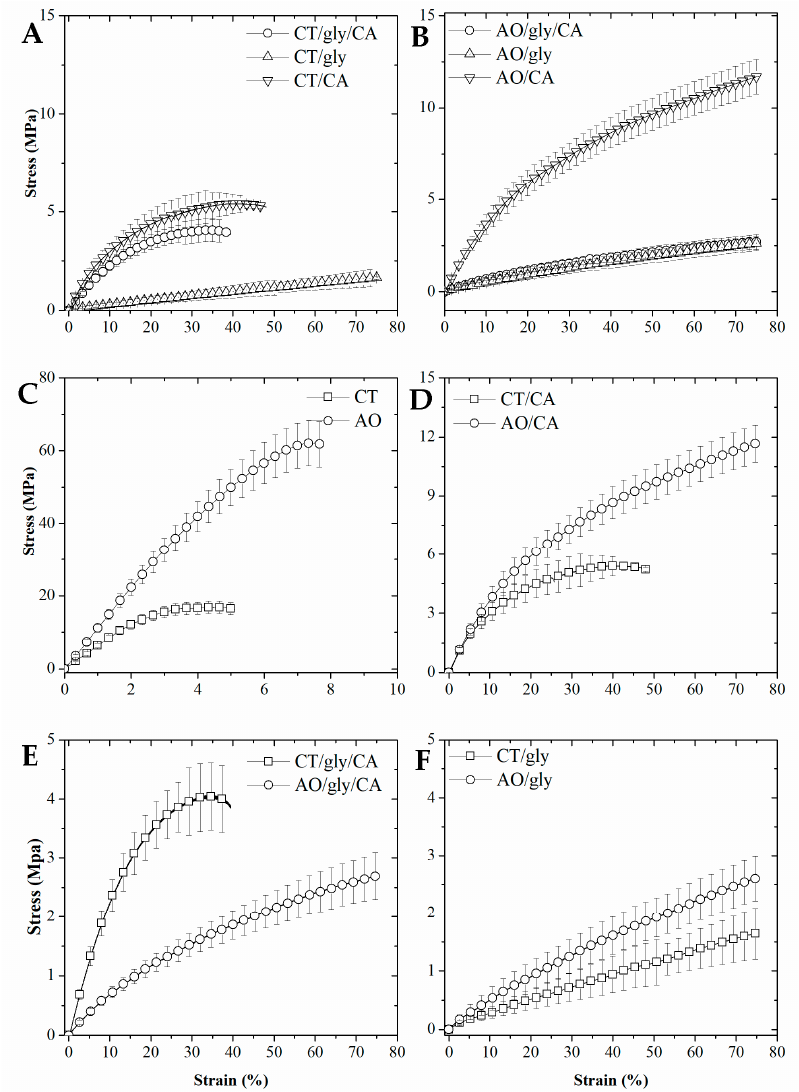
Figure 4. The stress and strain of extruded samples. ( A ) Control starch extrudates; ( B ) AO starch extrudates; ( C ) Comparison of pure starch (no glycerol) extrudates; ( D ) Comparison of extrudates cross-linked with CA; ( E ) Comparison of extrudates cross-linked and with glycerol; ( F ) Comparison of extrudates with glycerol. Error bar represent the standard deviation.